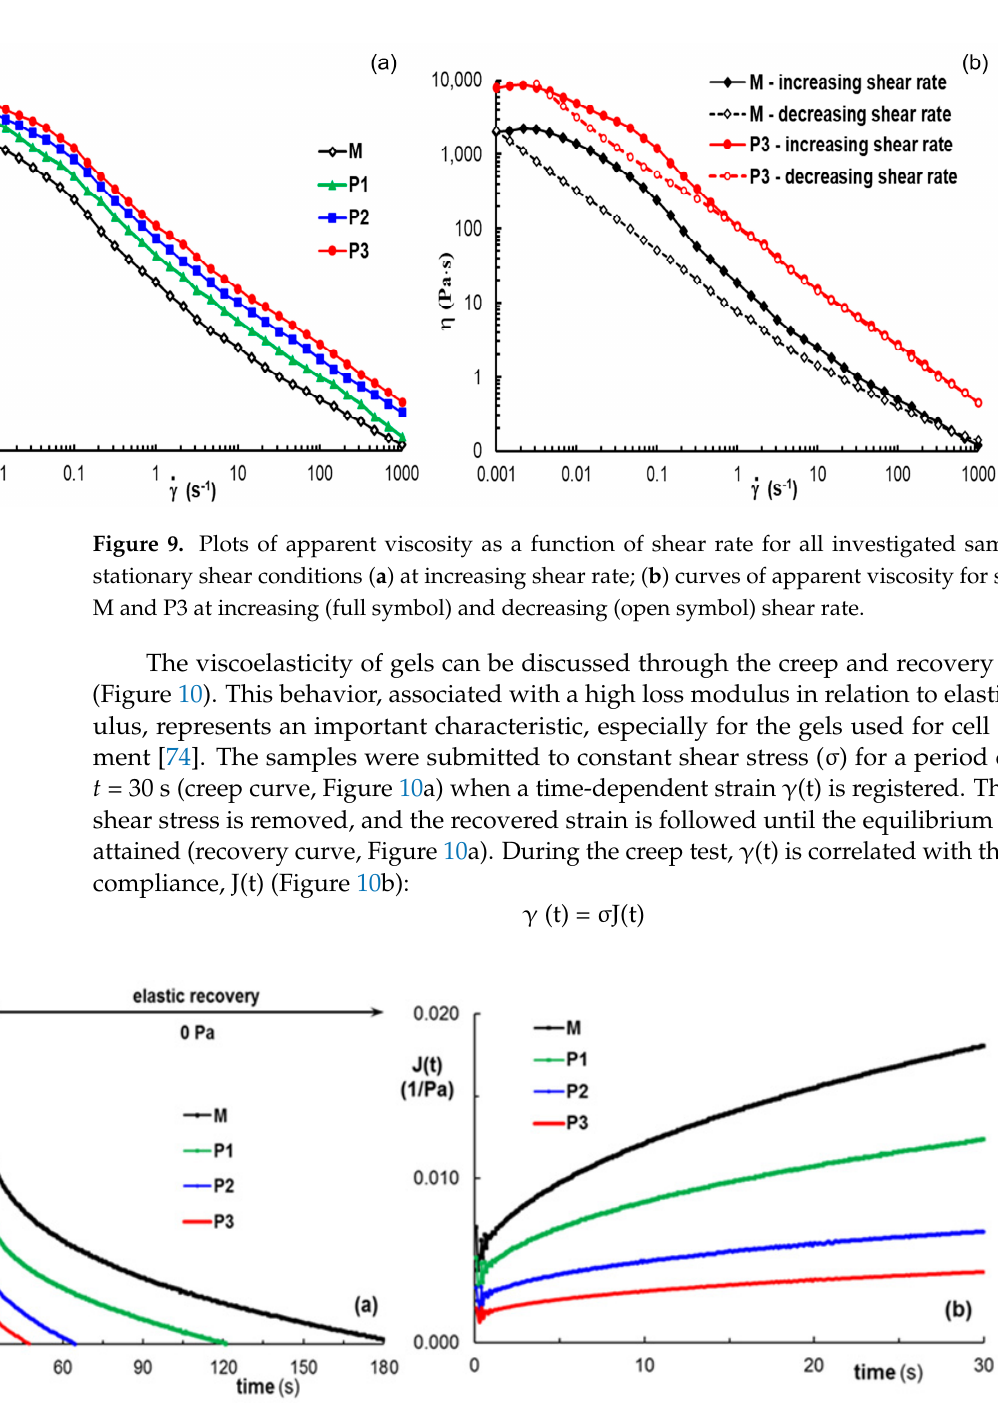
Figure 10. The behavior of gel samples (M, P1, P2 and P3) during creep at 2 Pa ( a ) strain during creep and recovery tests ( b ) J(t) during creep tests.